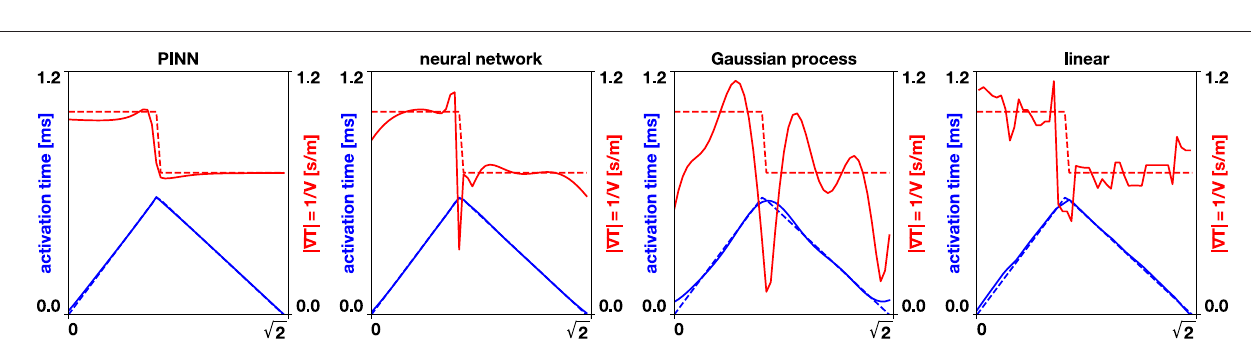
FIGURE 3 | Benchmark problem x = y line. The dashed lines show the exact analytical solution, the solid lines the different interpolation methods. The physics-informed neural network (PINN) captures the gradient of the activation times produced by the collision of two wavefronts and closely predicts the conduction velocity. The neural network and Gaussian process regression produce a smooth interpolation that generates oscillating conduction velocities, especially near the collision of the two wavefronts. The linear interpolation produces an approximation that is highly sensitive to the position of the data